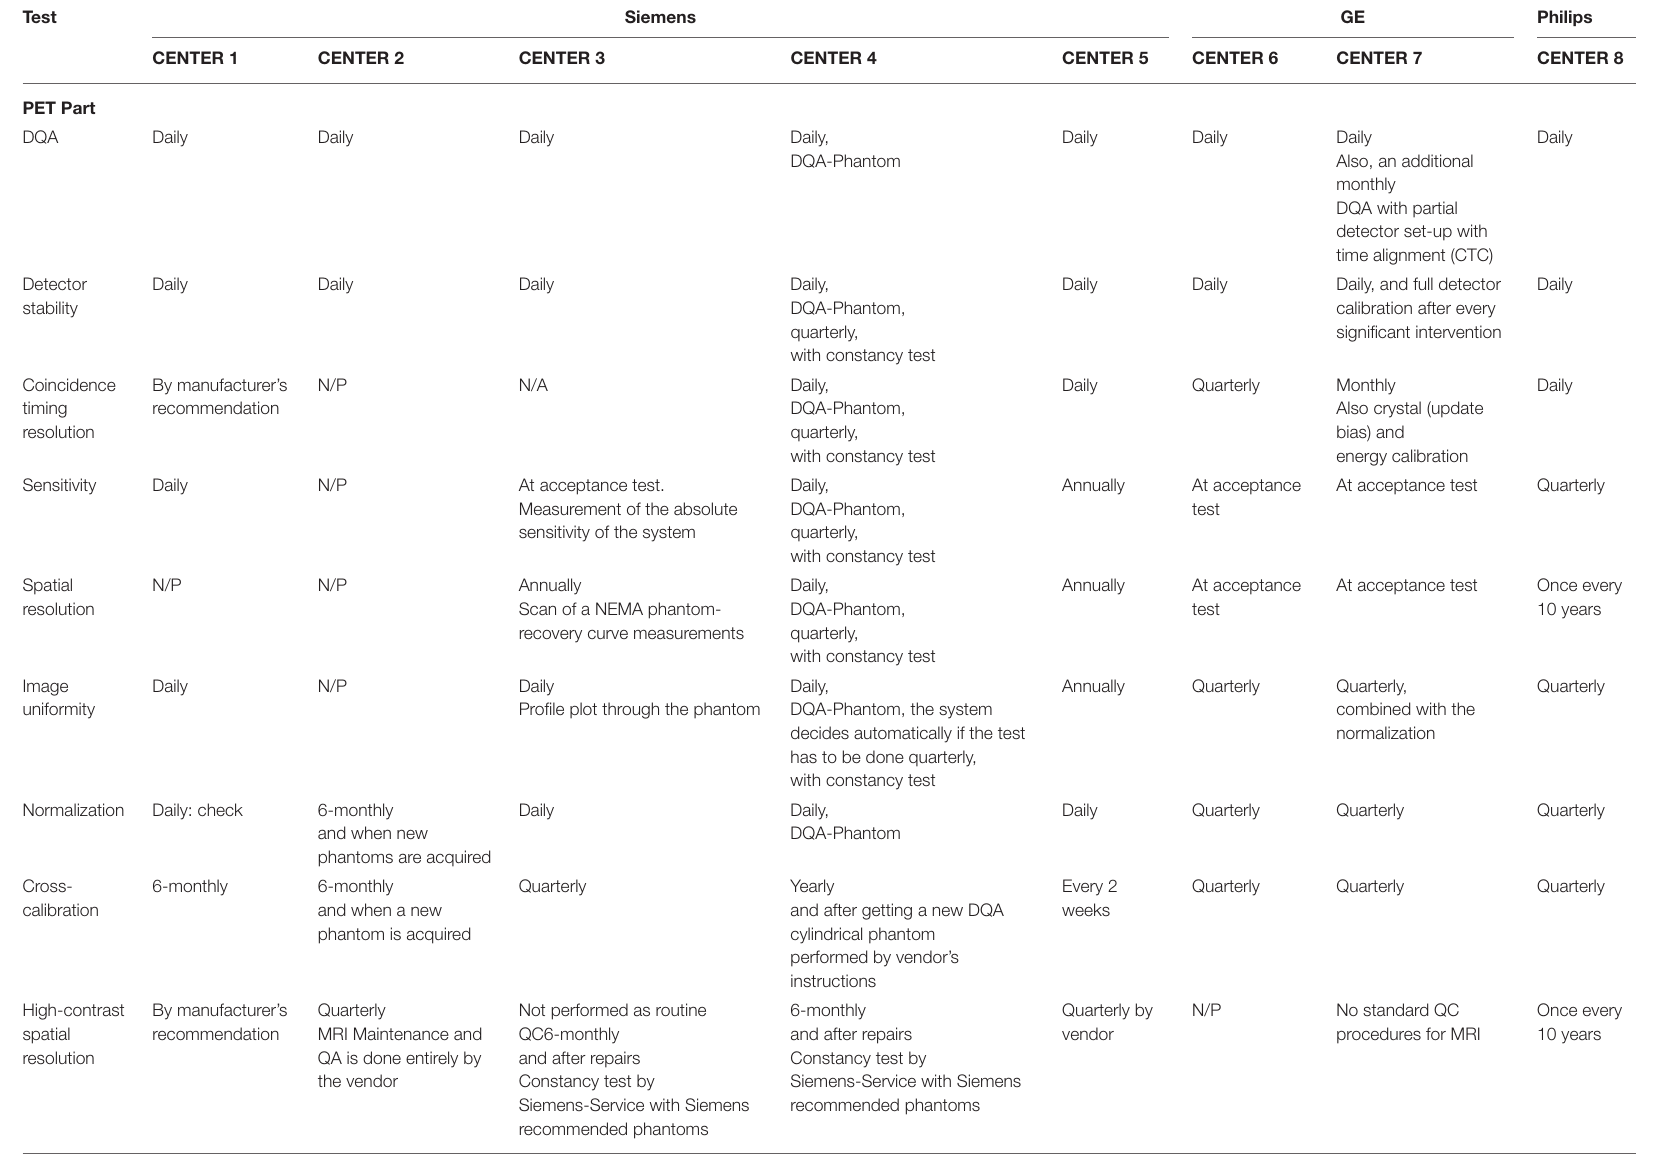
TABLE 3 | Performed QC tests and testing frequencies for PET/MRI systems across the participant